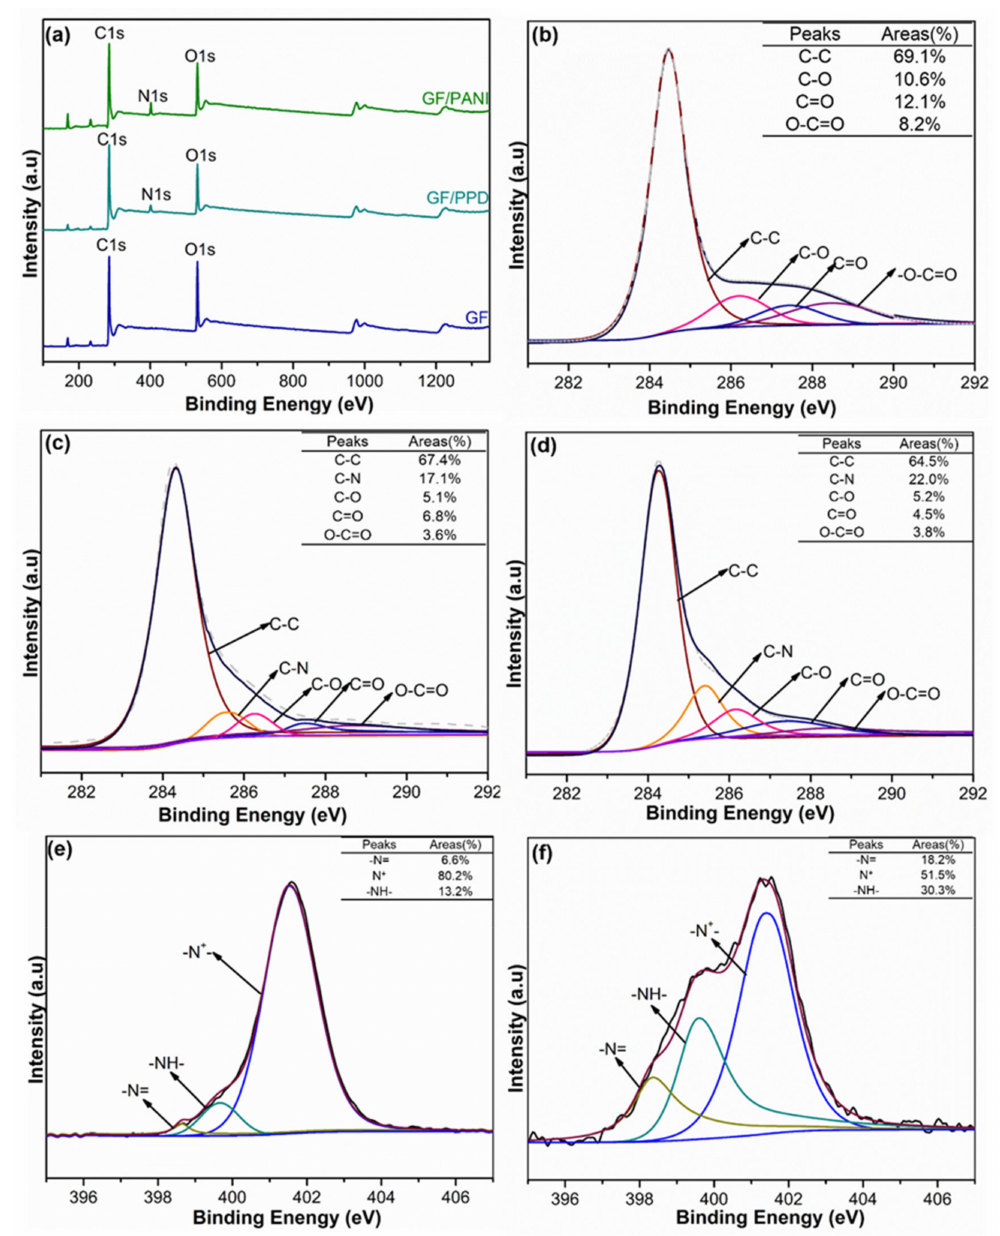
Figure 6. ( a ) The full XPS spectra of GF, GF/PPD, and GF/PANI membranes. C 1s spectrum of ( b ) GF, ( c ) GF/PPD, and ( d ) and GF/PANI; N 1s spectrum of ( e ) GF/PPD and ( f )